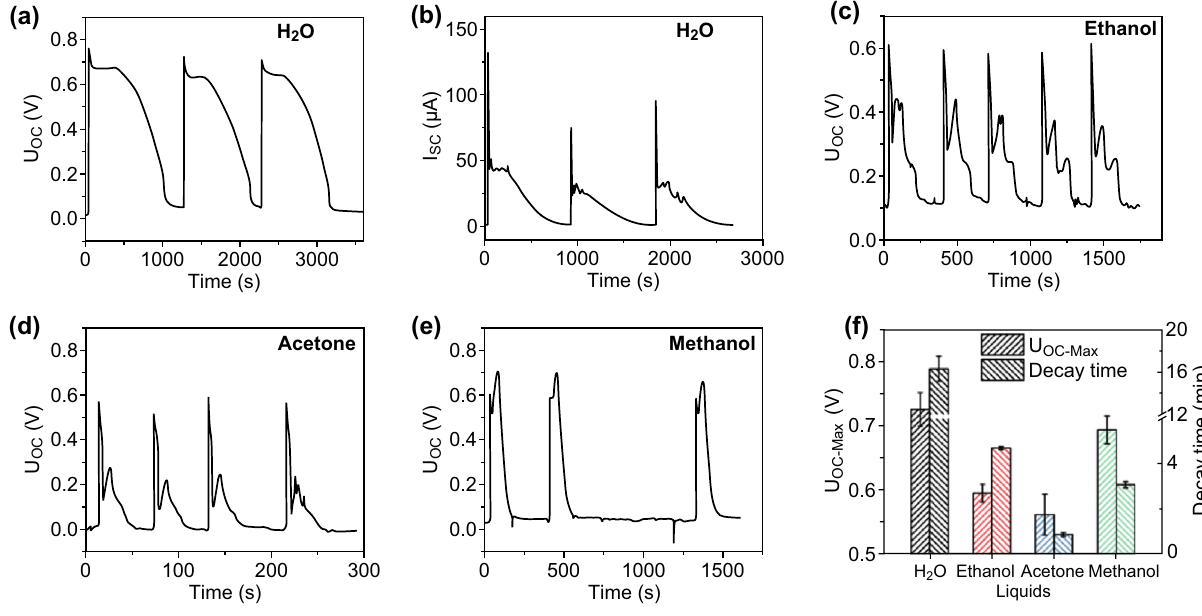
Fig. 3 a U OC , b I SC response of the C-T generator when 6 µL of liquid water is dropped on the device. After U OC measurement, the C-T genera- tor was left in the ambience to dry, followed by the I SC test. The voltage response of the C-T generator to similar quantities of liquid ethanol, acetone, and methanol is shown in c – e , respectively. f Maximum U OC and decay time for the C-T generator on exposure to different